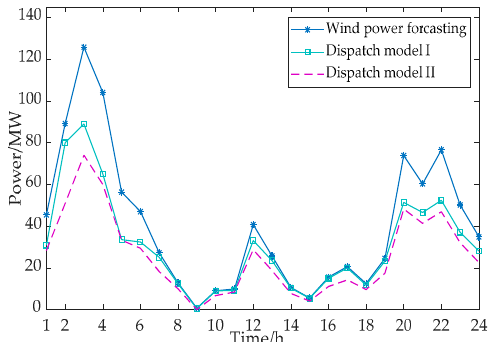
Figure 15. Comparison of the emissions of SO 2 and NO x .